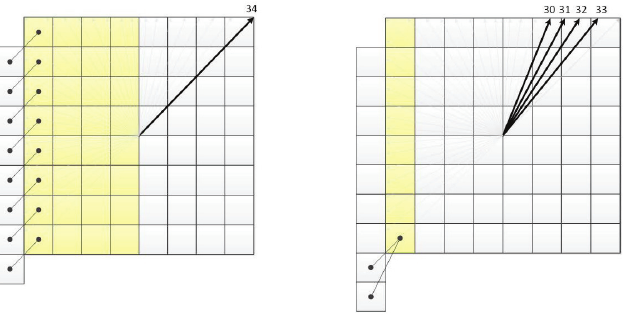
Figure 6. Examples of limit prediction filters for intra-modes corresponding to modes 30–34 in HEVC [15].